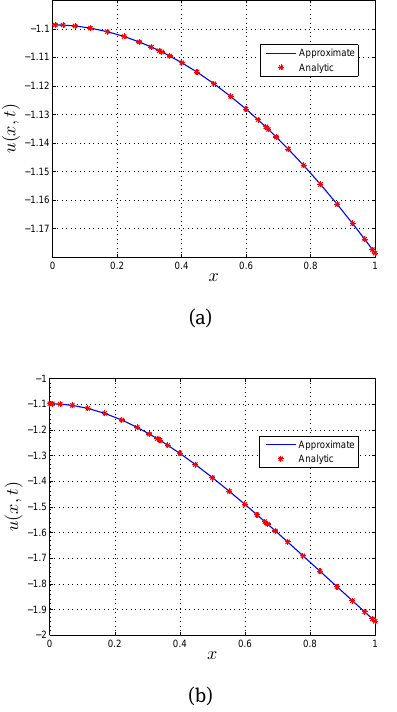
Figure 6: Analytical and approximate solution for example 5 at (a) t = 0.5 and (b) t =